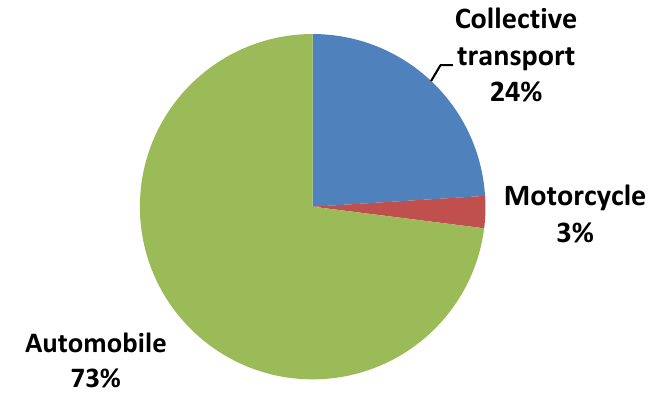
Figure 6. Consumption of energy by type, 2008. Source: ANTP [39].